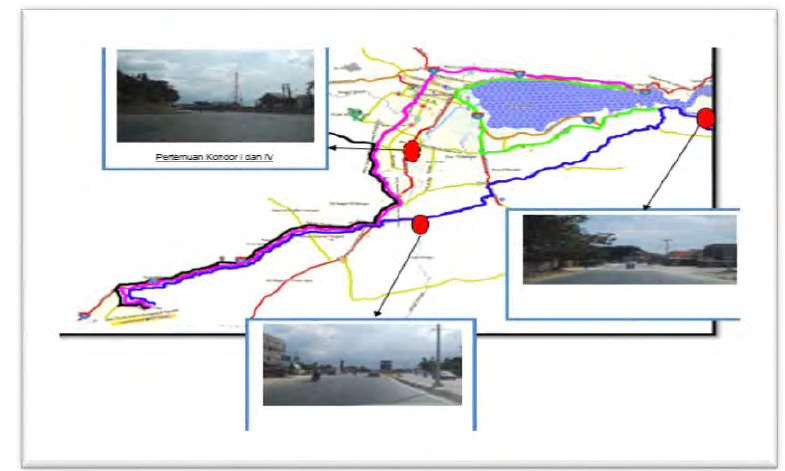
Figure 6. Map of the intersection of Corridor I, II, III and